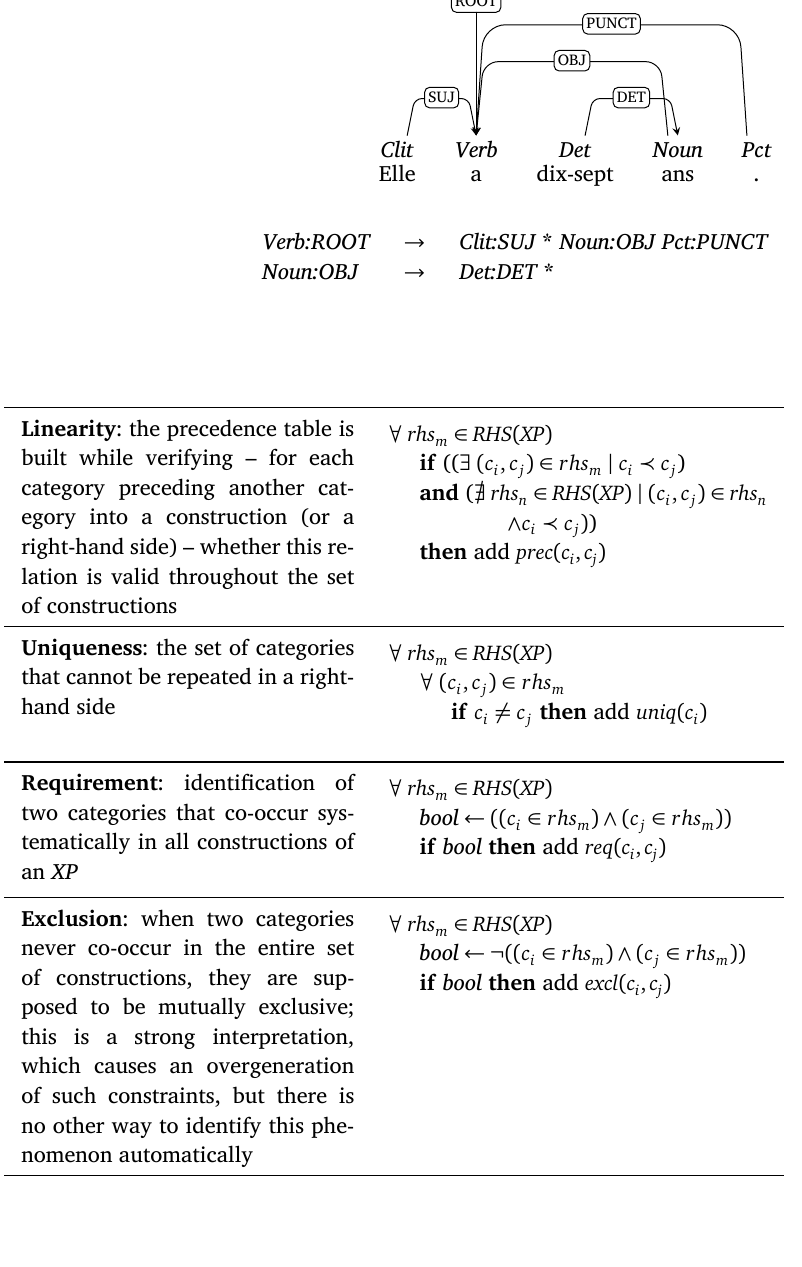
Figure 4: Dependency tree and inferred